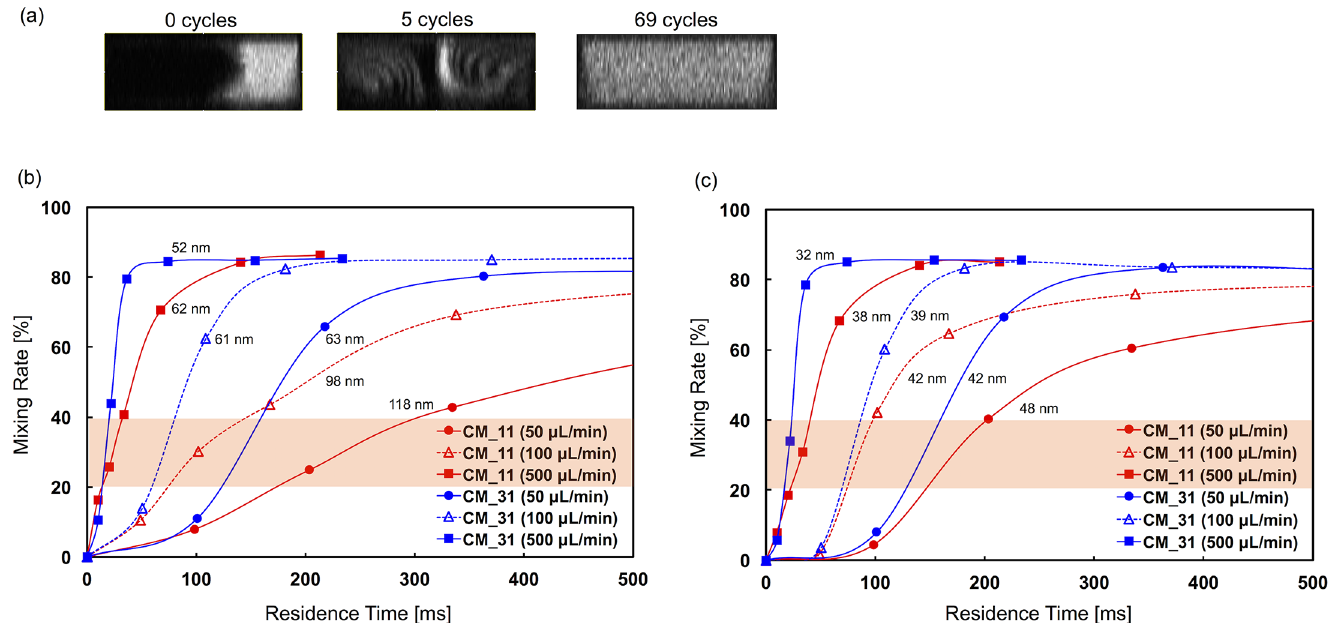
Fig 6. Evaluation of mixing performance of the microfluidic devices. (a) The confocalimages of a cross section of the CM_31 device at different positions.The measurement positionsof the images were before passingthrough the mixer structures (0 cycles), and after passingthrough the 5th and the 69th mixer structures. The flow conditionswere 100 μ L/min and FRR of 3. (b-c) Comparison of the mixing rate for 500 ms betweenthe CM_11 and CM_31 devices at (b) FRR of 3 and (c) FRR of 9. The plots represent the mixing rate after passingthrough the 1st, 5th, 10th, 23th, 46th, and 69th chaotic mixer structures. The mixing rate in the entire microchannel is shown in S3 and S4